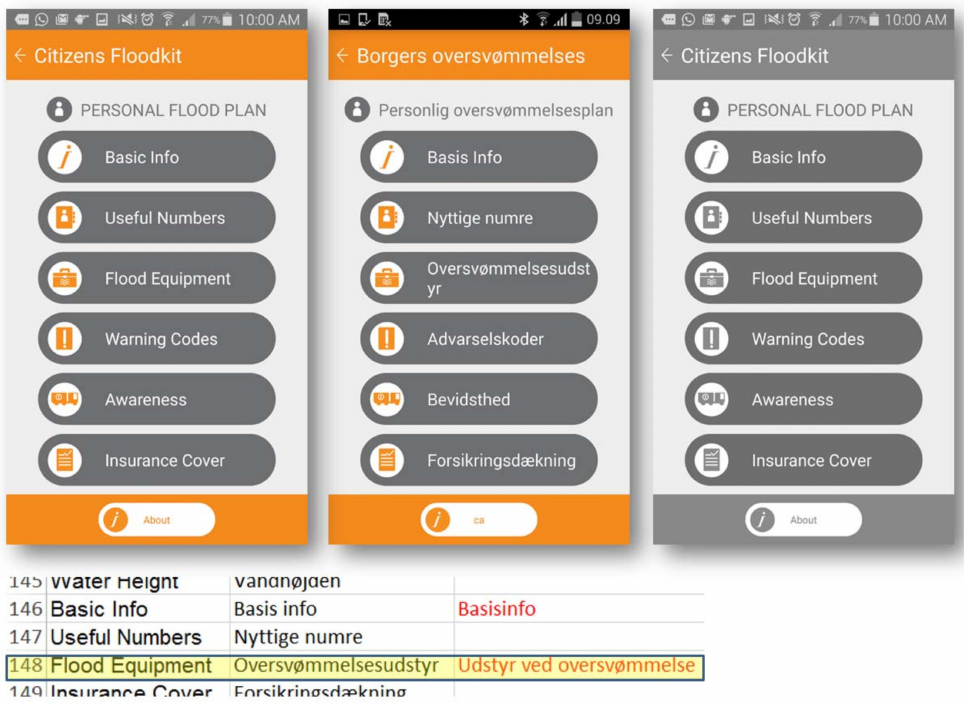
Figure 10. English version of screen contents and Danish translation during piloting. The third screen is the colorblind version.